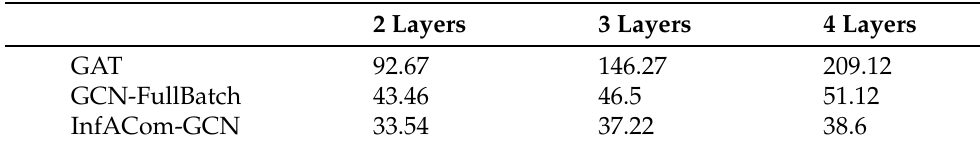
Table 2. Memory usage in megabytes for Cora dataset using different numbers of layers (the number of hidden units is 128).